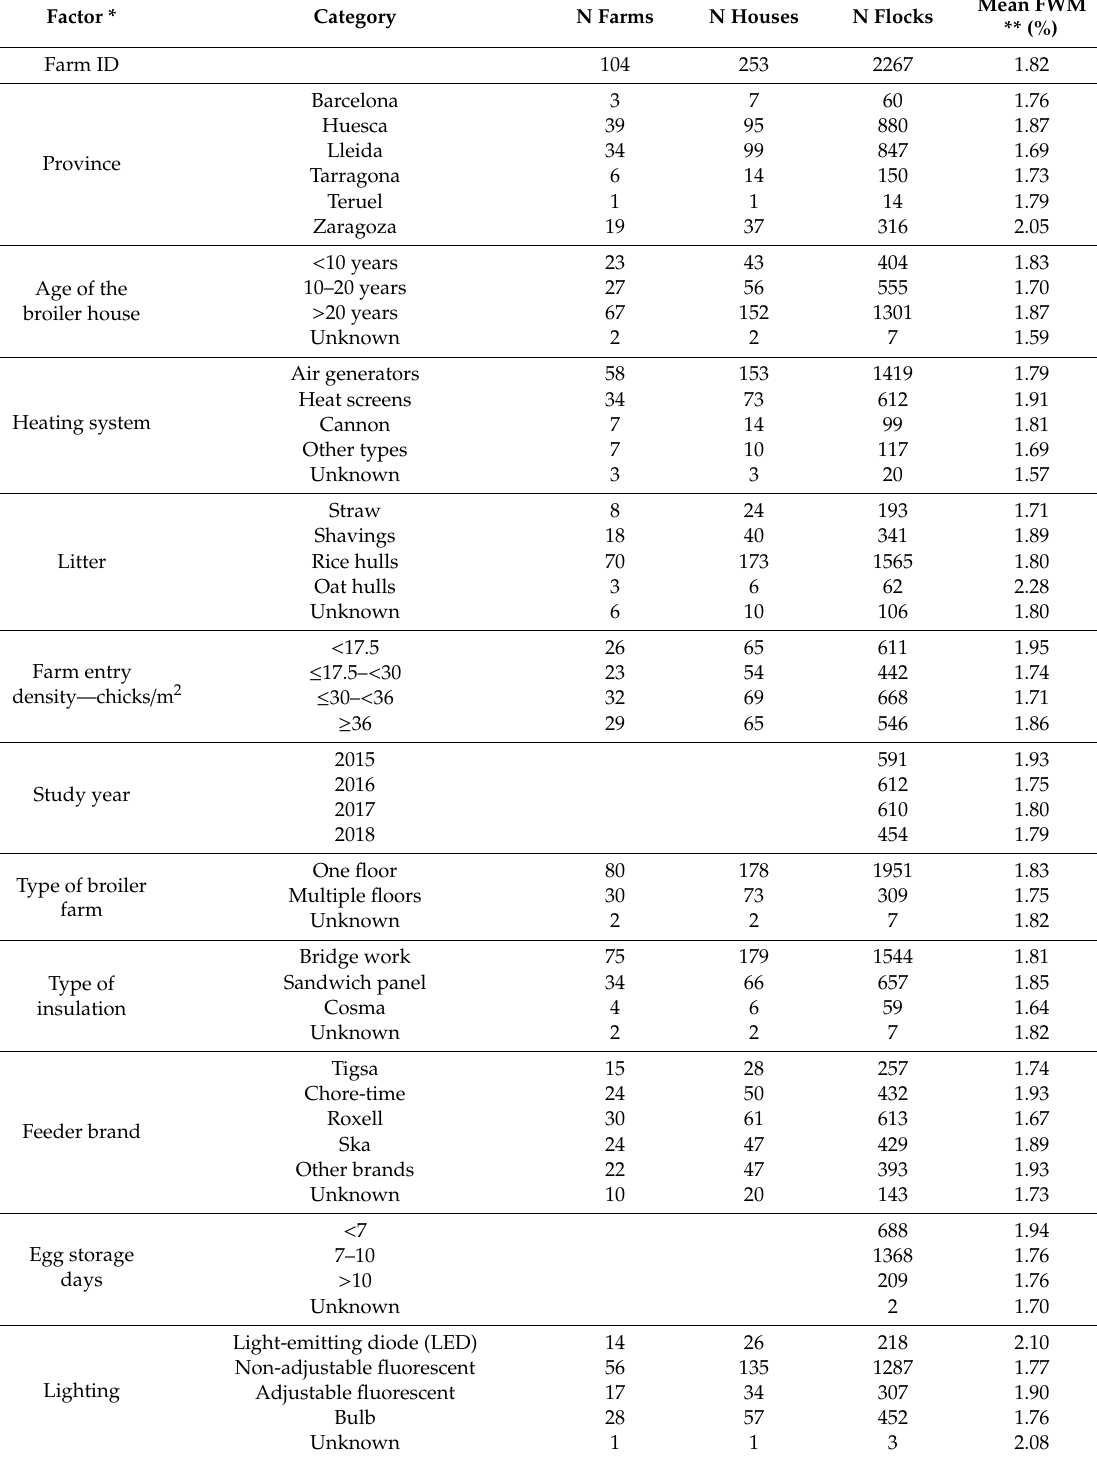
Table 1. The list of independent variables classified as external (environmental or management) and internal (individual-specific) factors, and the total mean cumulative mortality during the first week of life (study of 2267 flocks in 104 farms and 253 broiler houses, Spain, 2015–2018).